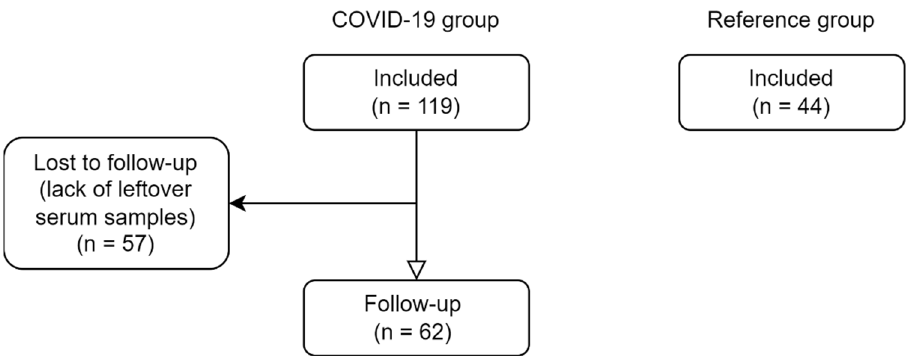
Figure 4. Schematic illustration of the study design. Anthropometric and clinical data were collected from the patients’ records.